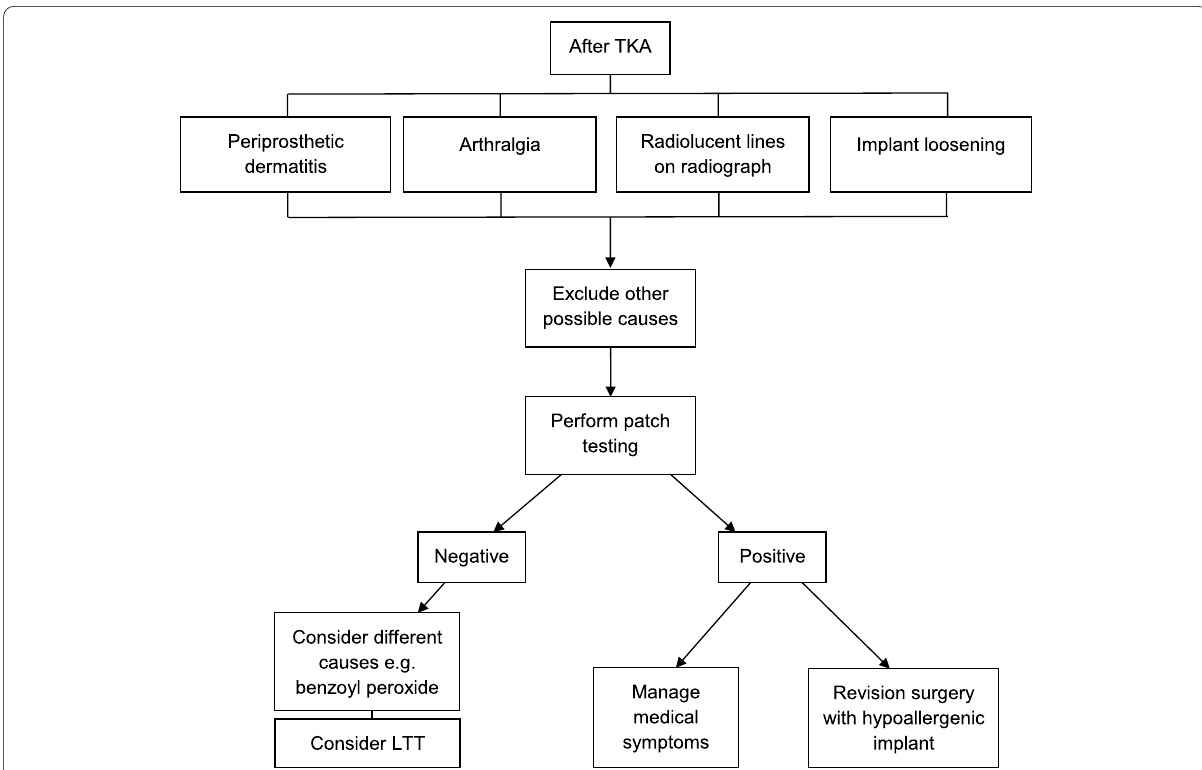
Fig. 3 Treatment algorithm for Nickel hypersensitivity in patients after total knee arthroplasty (TKA) (adapted from Mitchelson et al.